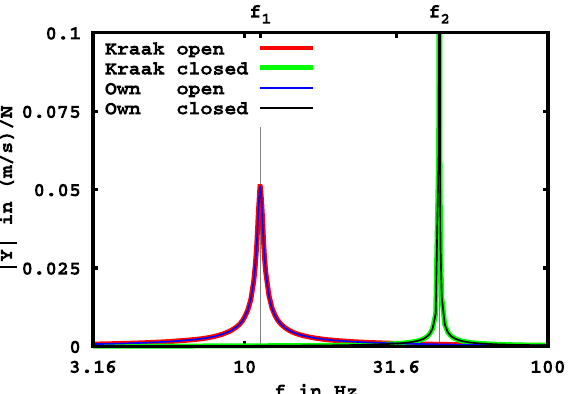
Figure 4. Magnitude of the admittance at the point of excitation. Comparison of different fl ow resistivities r (unit: Pa s/m 2 ), scaled to achieve a value of 1 at the maximum, which is emphasized by dots.